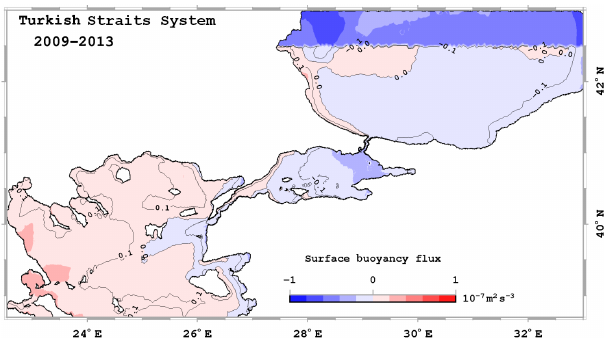
Figure 4. Mean of surface buoyancy fluxes for 2009–2013. A neg- ative value is the buoyancy flux down into the